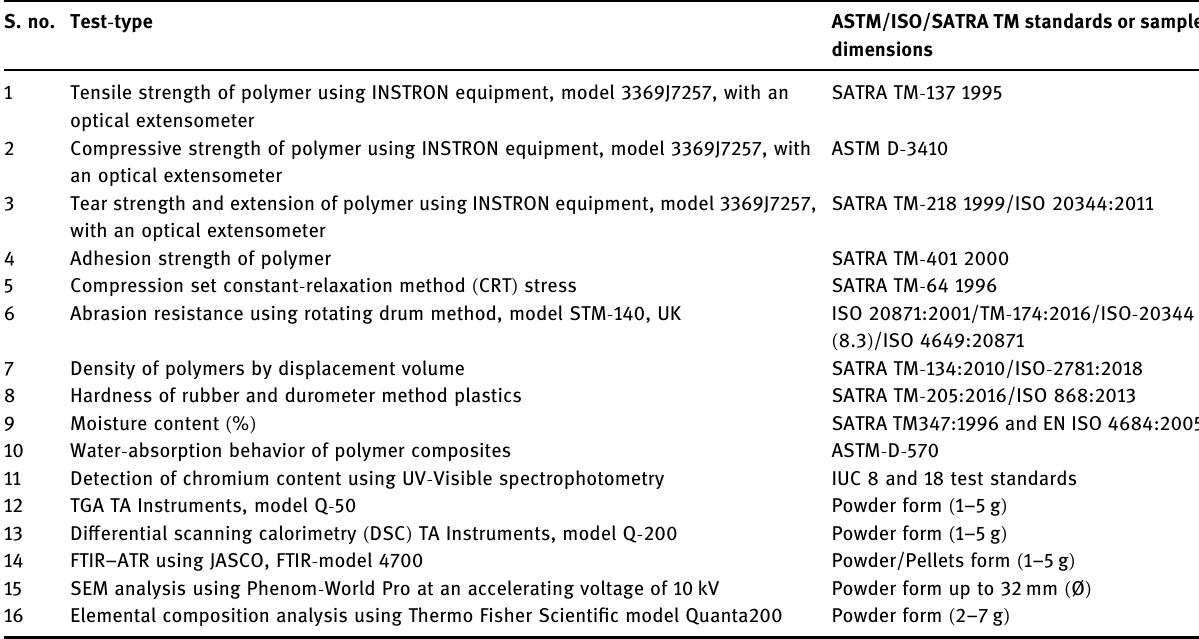
Table 2: Standard test methods and specimen standards used in this study S. no. Test -